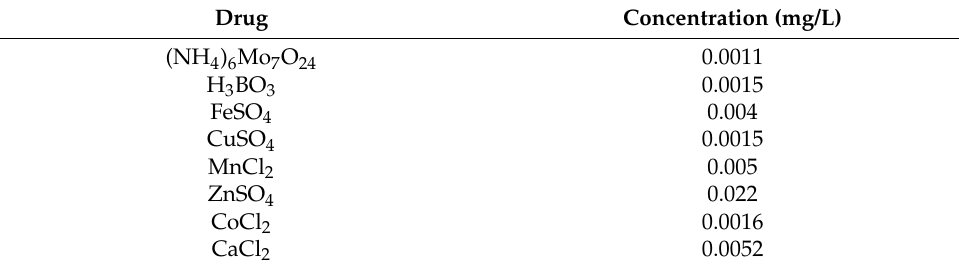
Table 4. Trace element